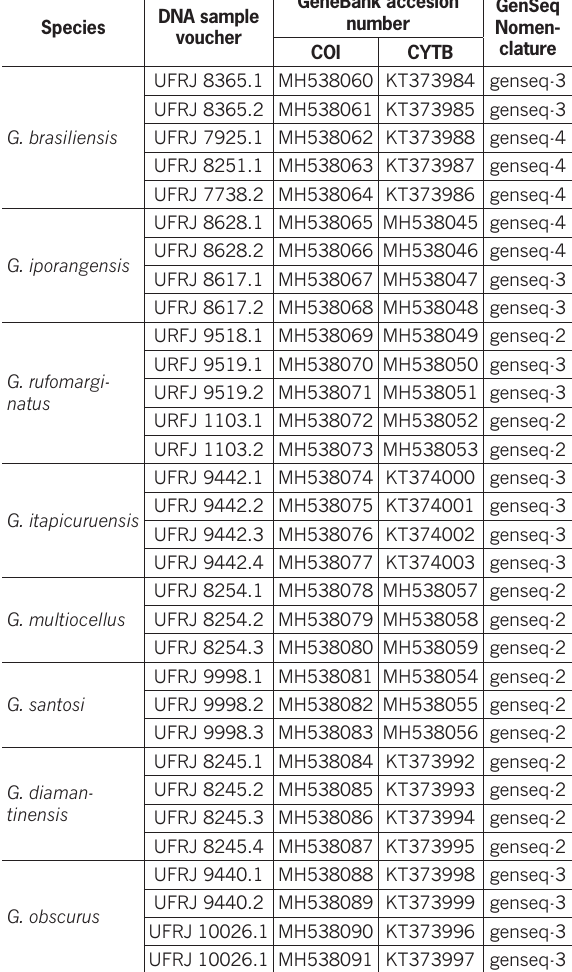
Table 1. Vouchers and GenBank accession numbers for new se - quenced material of Geophagus .